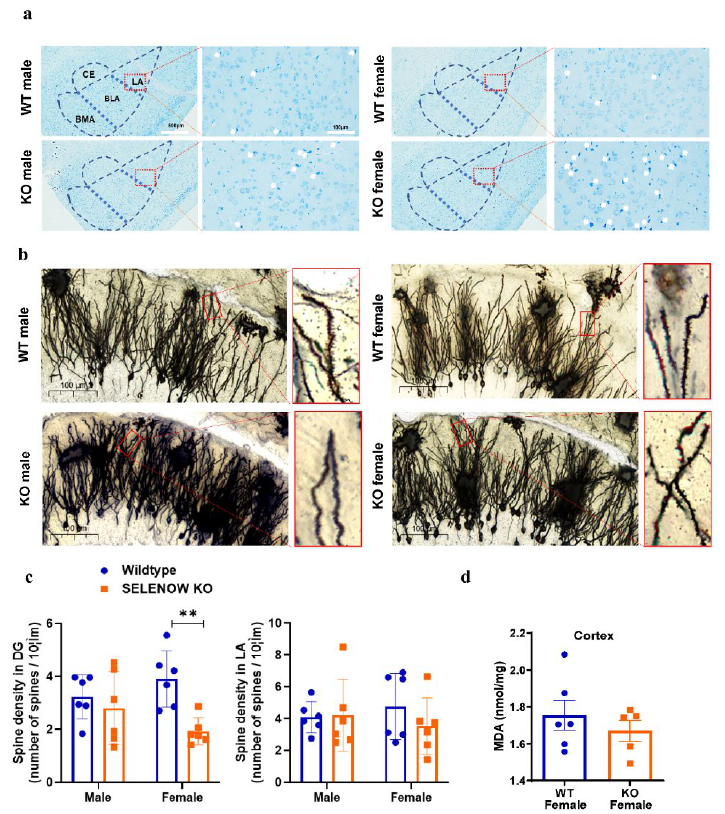
Figure 3. Staining and MDA detection of representative brain sections in WT and KO mice. ( a ) Nissl staining of amygdala in 6 month old WT and KO mice. The subregions of the amygdala, including the lateral amygdala (LA), basolateral amygdala (BLA), basomedial amygdala (BMA), and central amygdala (CE), are shown in the blue, dashed lines. Images on the right are LA areas, enlarged in the red box. White arrows indicate the small and darkly stained injured neurons that were charac- terized by cytoplasmic shrinkage, nuclear pyknosis, and hyperchromasia. ( b ) Golgi staining of the hippocampus DG area and typical dendrites in 6 month old WT and KO mice. ( c ) Statistics and analysis of spine density in DG and LA. The dendrite length and spine numbers were measured by ImageJ. Spine density was defined as the spine numbers per 10 μm of dendritic length ( n = 6). Data are expressed as the mean ± SEM (two-way ANOVA followed by Sidak’s multiple comparisons test). ** p < 0.01. ( d ) MDA levels in the cortex of 6 month old female WT and KO mice. Data are expressed as the mean ± SEM (Student’s t -test, n = 6 in WT and n = 5 in KO). 3.3. Identification of DEPs by TMT-Based Quantitative Proteomic Analysis As described above, only the female KO mice displayed the phenotype of fear memory deficit with histomorphological alteration in amygdala and hippocampus. To further elucidate which proteins and pathways were affected by SELENOW deletion in the contextual memory retrieval process of female mice, we conducted TMT-based prote- omic analysis for both the hippocampus and amygdala collected after the CFC testing stage. The group design and the workflow of the TMT proteomic experiments are pre- sented in Figure 4a.